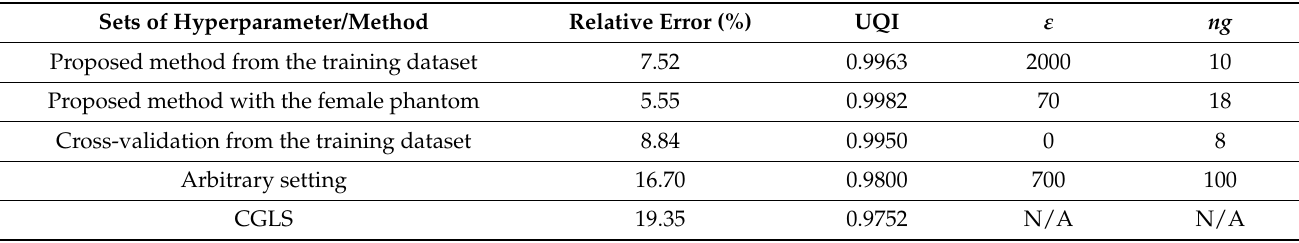
Table 6. Relative errors and UQI of image reconstruction results from the female phantom using each set of hyperparameters and the CGLS algorithm